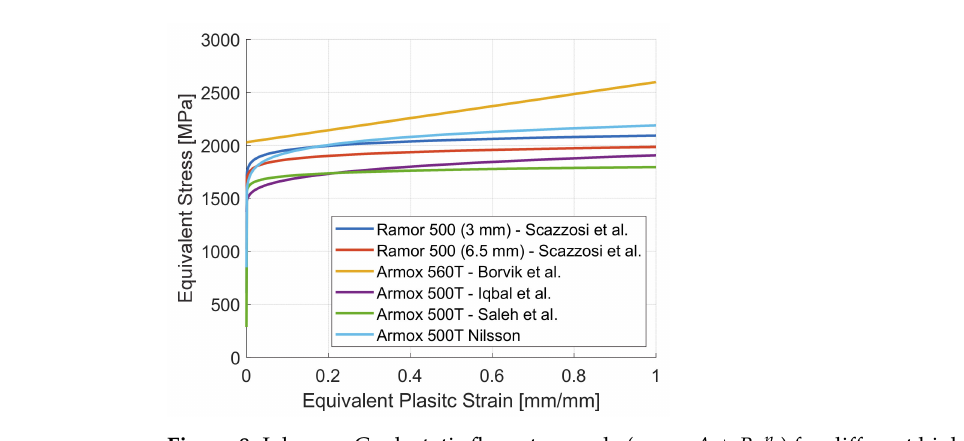
Figure 8. Johnson–Cook static flow stress rule ( σ eq = A + B (cid:101) n eq ) for different high strength steels.